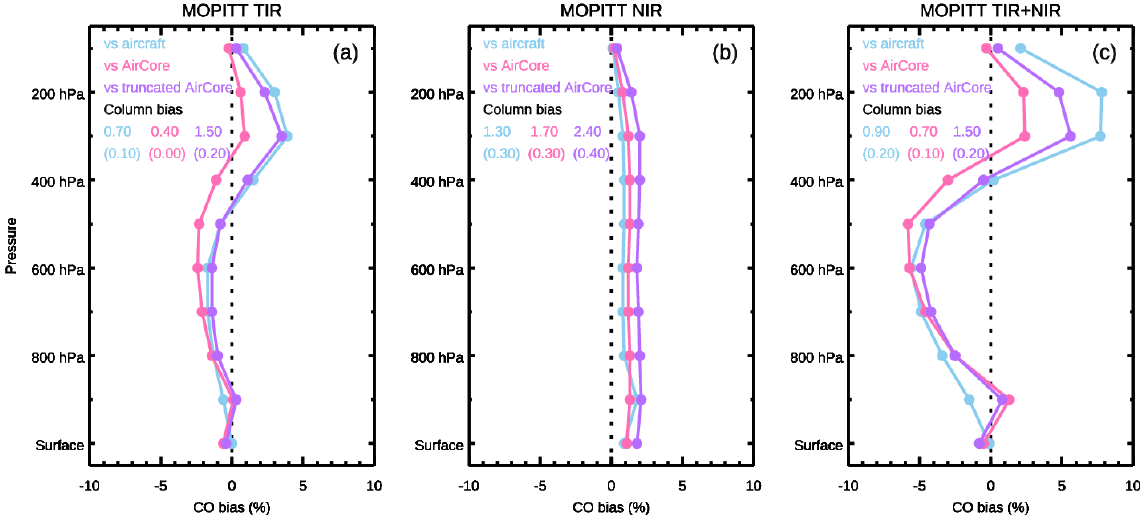
Figure 4. CO biases for the 2012–2019 period from the comparison of MOPITT with respect to NOAA aircraft flask data (blue), AirCore profiles (pink), and truncated AirCore profiles extended upwards (purple). (a) For MOPITT TIR. (b) For MOPITT NIR. (c) For MOPITT multispectral. Column bias values are provided in percent (%) and in units of 10 17 molec.cm − 2 (in parentheses). The ± 10% CO bias range is equal to the MOPITT target accuracy (Francis et al., 2017). Table 2. Statistics from the comparison of MOPITT CO with respect to truncated AirCore profiles extended upwards. Column bias and SD are provided in percent (%) and in units of 10 17 molec.cm − 2 (in parentheses). Column bias r from VMR values (in parentheses) are lower than r from percent values because VMR results are presented in terms of log(VMR), after subtracting the a priori values (see Deeter et al., 2017); thus, the a priori variability does not contribute to the correlation. Partial column relative bias and SD in %. Partial column results only shown for even pressure levels, for simplicity. Total column Surface 800hPa 600hPa 400hPa 200hPa MOPITT TIR vs truncated AirCore